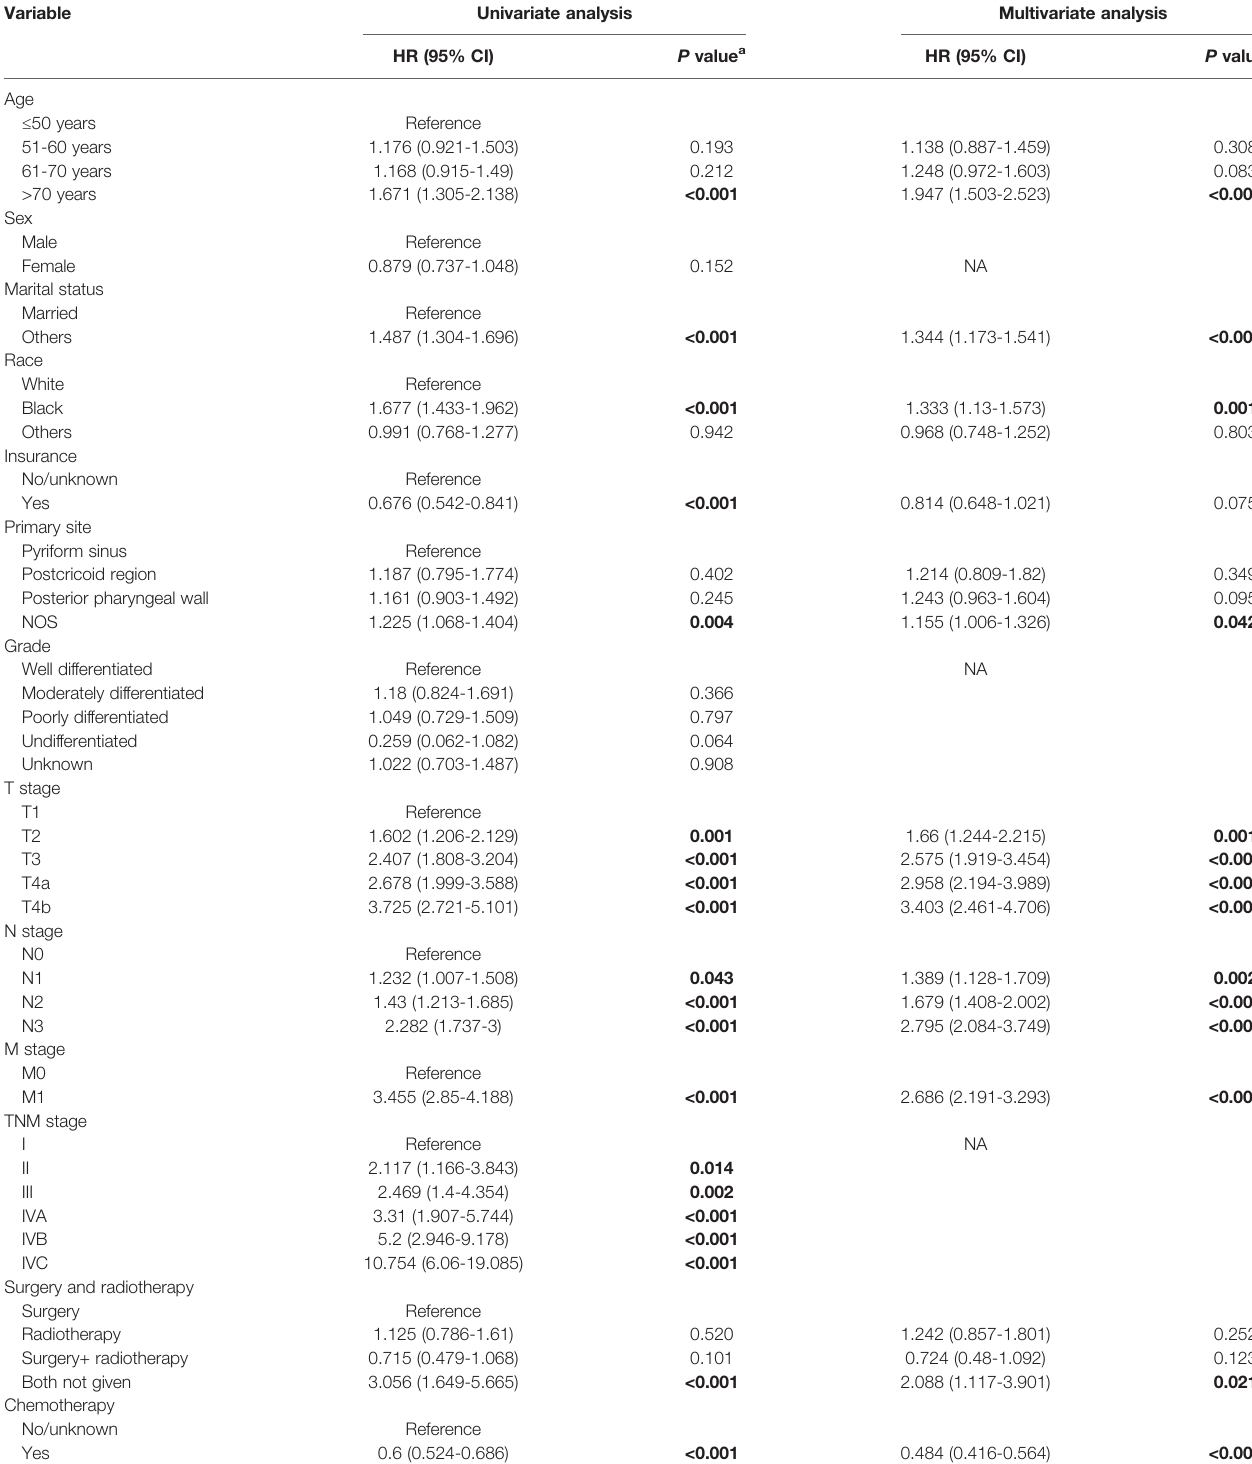
TABLE 2 | Univariate and multivariate analyses of overall survival in the training